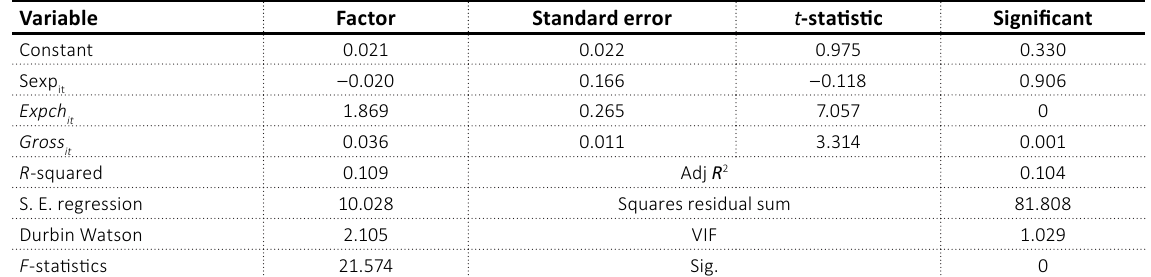
Table 7. Model 3